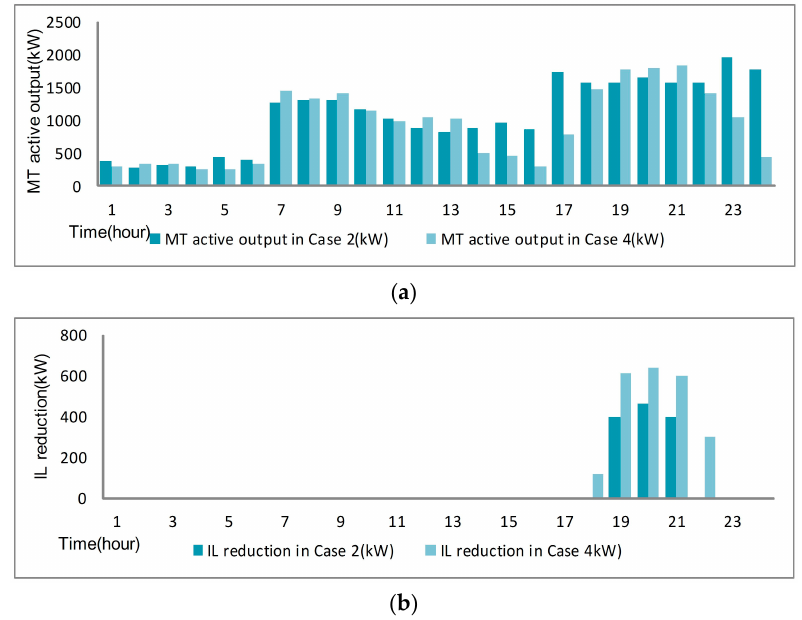
Figure 9. Comparisons of DER outputs in each hour between case 2 and case 4. ( a ) Comparison of MTs active power outputs in each hour between case 2 and case 4; ( b ) Comparison of ILs reduction in each hour between case 2 and case